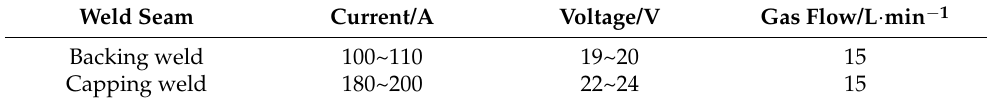
Table 3. Welding parameters for 900QC steel.